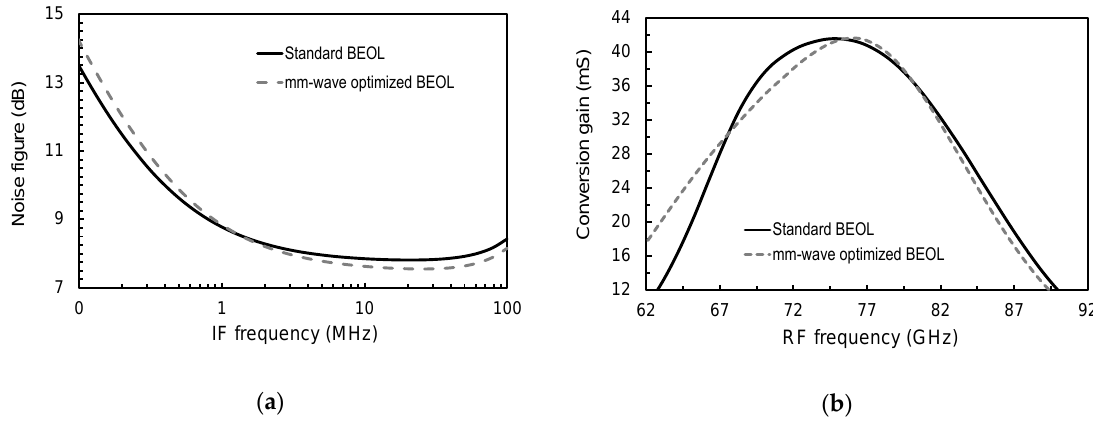
Figure 12. Down-converter performance: ( a ) NF as function of the IF frequency; ( b ) short-circuit transconductance conversion gain as function of the RF frequency. Table 3. Summary of the 28 nm CMOS down-converter performance in the two compared BEOLs. Parameters